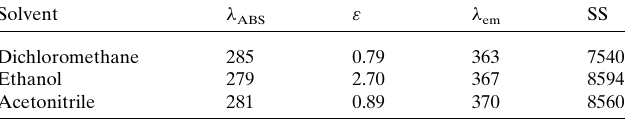
Table 2 Relevant photophysical data of the UV–Vis absorption and fluorescence emission spectroscopy, where (cid:7) ABS and (cid:7) em are the absorption and emission maxima, respectively (nm), " is the molar absorptivity coefficient ( (cid:7) 10 4 M (cid:3) 1 cm (cid:3) 1 ) and SS is the Stokes shift (cm (cid:3) 1 ).